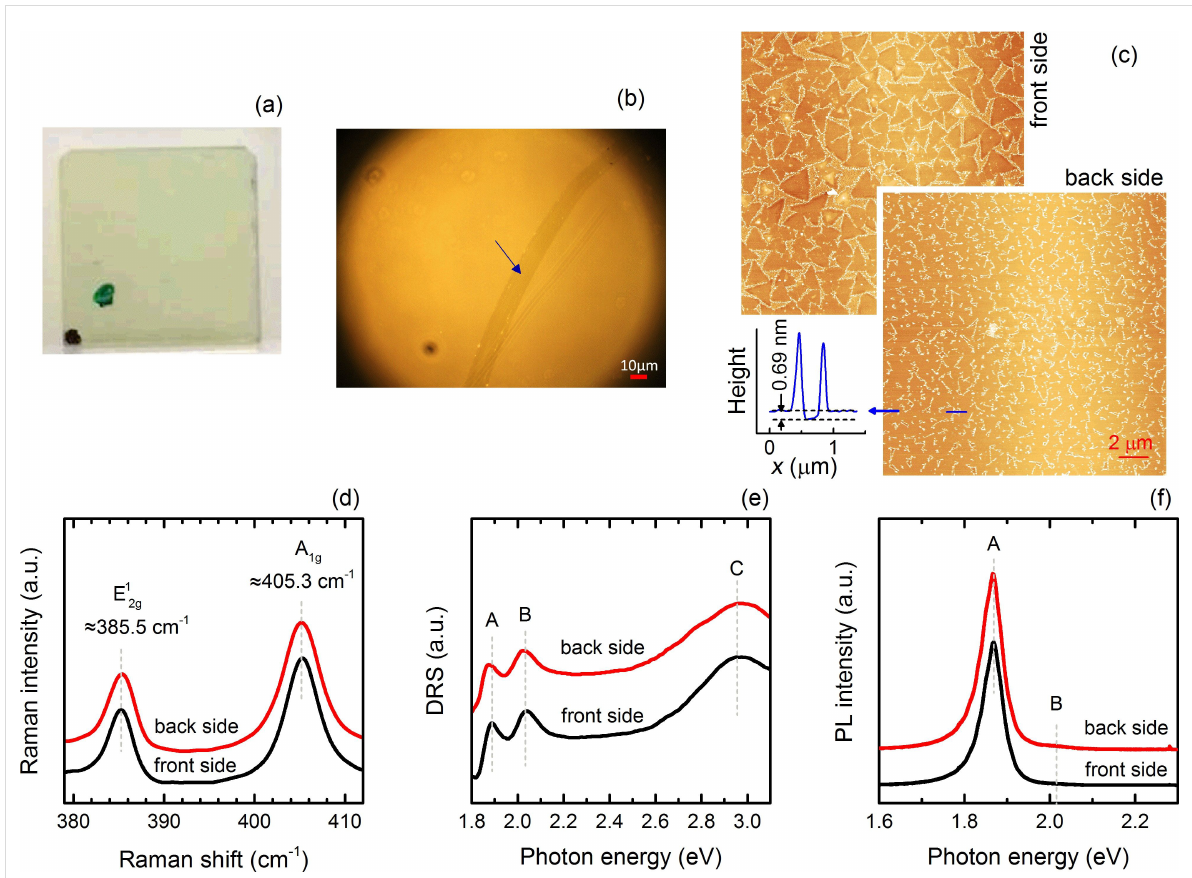
Figure 1: The results of the ex situ characterization. (a) A photograph representing the 10 × 10 mm substrate after CVD growth. The black and green dots marked on the front and back sides of the substrate, respectively, are used to distinguish between the two surfaces. (b) Optical microscopy image taken from the surface at the front side of the same substrate. A scratch is indicated by the arrow. (c) AFM images recorded from the surfaces at the front and back side of the substrate, respectively. The height profile is measured along the blue solid line in the image. (d), (e) and (f) The Raman, differential reflectance, and photoluminescence spectra recorded on the surfaces at the front and back side of the substrate,